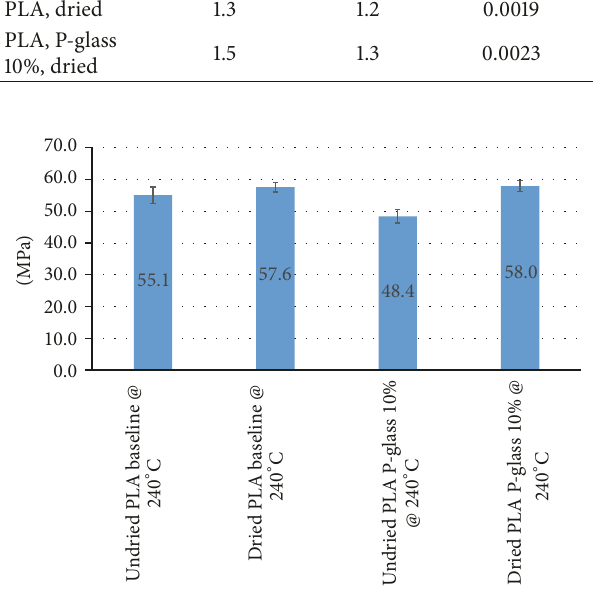
Figure 19: UTS values of undried versus dried PLA for the cases of neat resin and resin loaded with 10% by weight